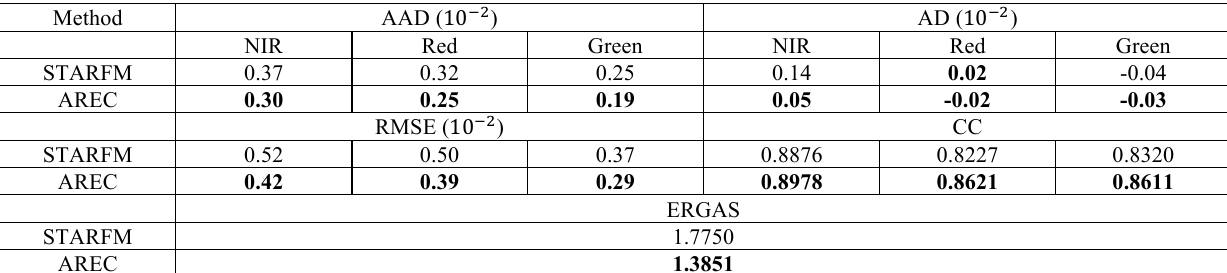
Table 2. The Shenzhen data set fusion results evaluated by objective indexes for STARFM and AREC methods